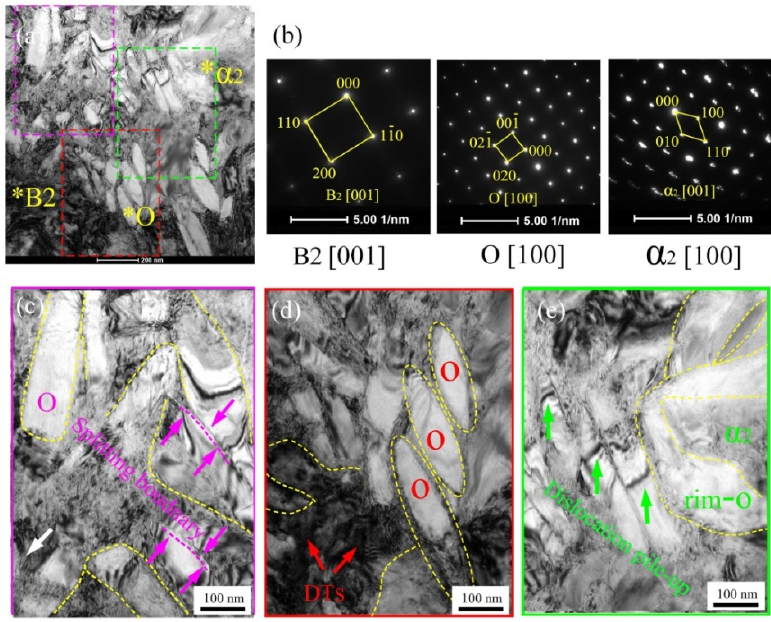
Figure 10. TEM micrographs of initial welded tube ( ψ t = 0%): ( a ) bright field figure, ( b ) selected area electron diffraction of ( a ), ( c – e ) local enlarged figure with three features of ( a ). The position marked by * corresponds to the diffraction pattern of Figure 10b.